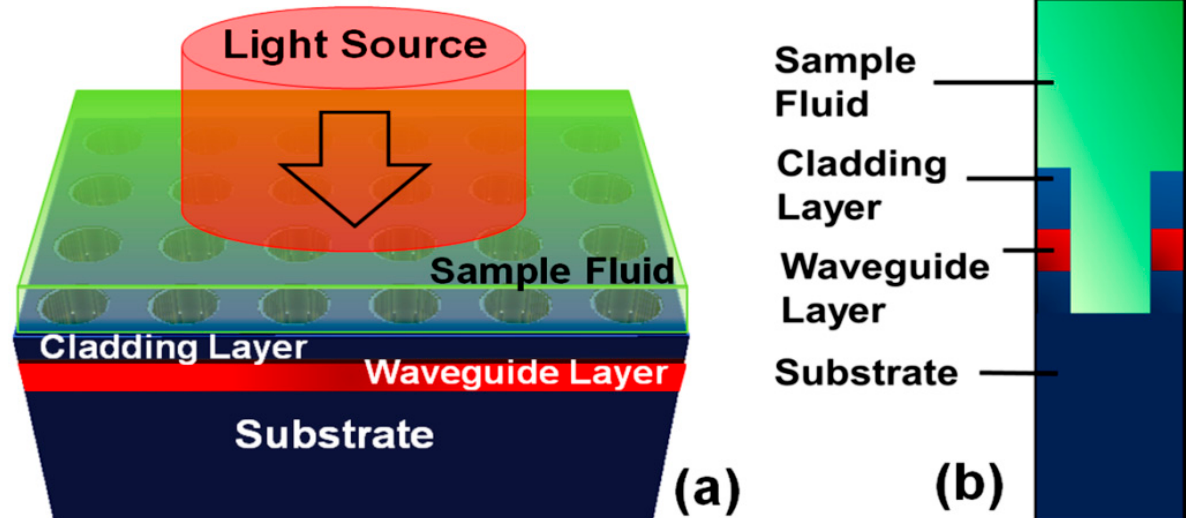
Figure 4. Numerical model of the nanosensor device. ( a ) Full 3D model of the device with the presence of a layer of the sample fluid on top of the PhC structure and an incident light beam. ( b ) Cross- sectional view of the unit cell model showing PhC structure and presence of the sample fluid.